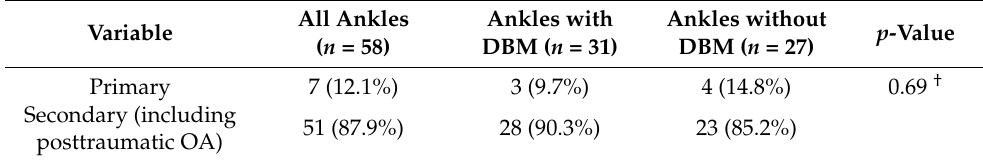
Table 3. Etiology of tibiotalar